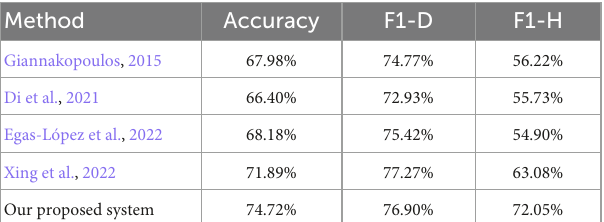
TABLE 9 Performance comparison of other literature studies on the depression speech